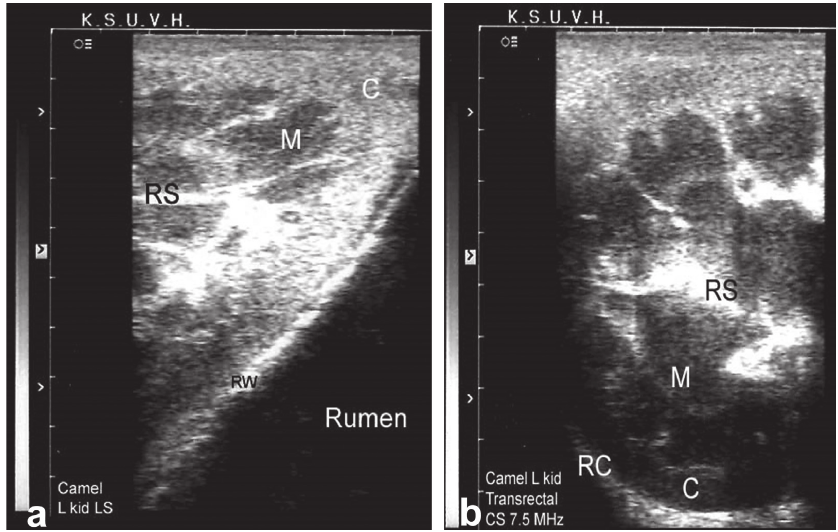
Figure 7: Transrectal ultrasonography of the left kidney in a healthy camel. The cranial pole of the left kidney is apparent (a). A cross- sectional view of the left kidney is also apparent (b). C � cortex; M � medulla; RS � renal sinus; RC � renal capsule; RW � rumen